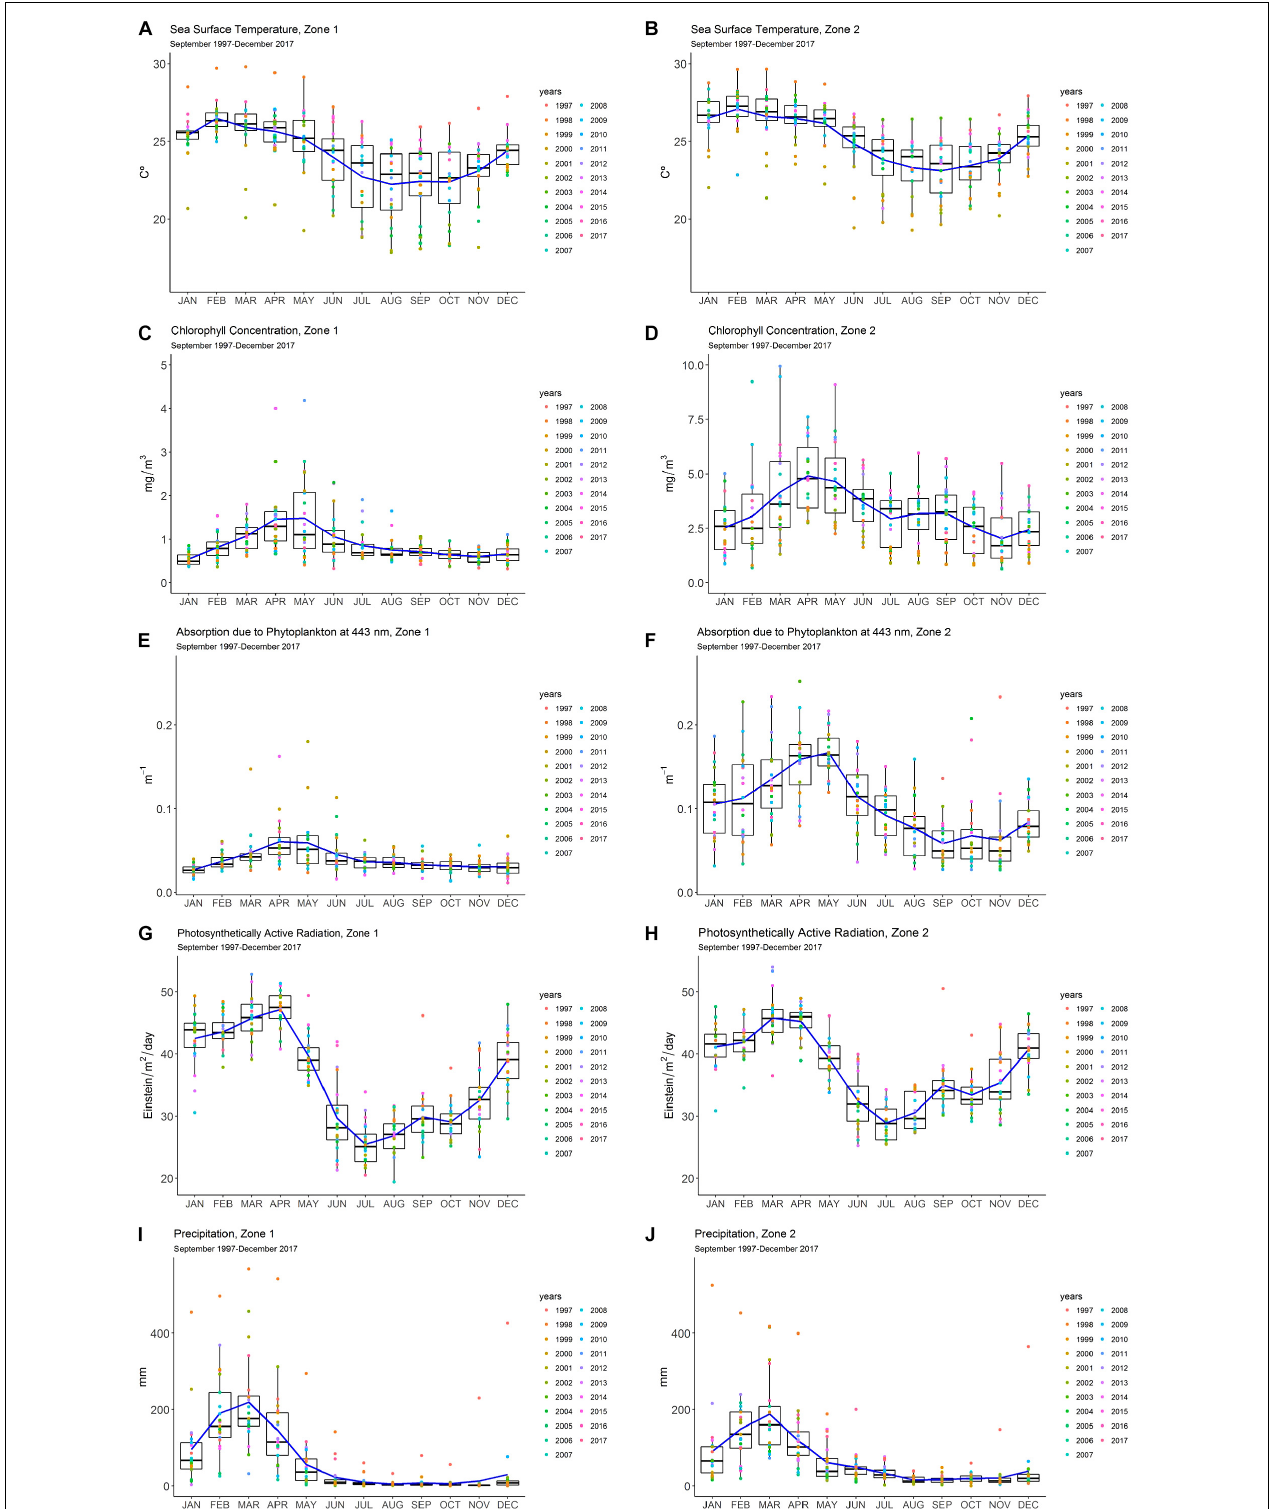
FIGURE 2 | Panel diagram of the monthly means of the remote sensing data of oceanographic variables: (A,B) sea surface temperature (SST); (C,D) chlorophyll a (chl-a); (E,F) absorption due to phytoplankton at 443 nm (aph); (G,H) photosynthetically active radiation (PAR) and atmospheric variable; (I,J) precipitation (PRE) for Zones 1 and 2 on the Ecuadorian coast (1997–2017). Seasonal pattern and inter-annual variability are shown with the blue line and the colored dots, respectively.